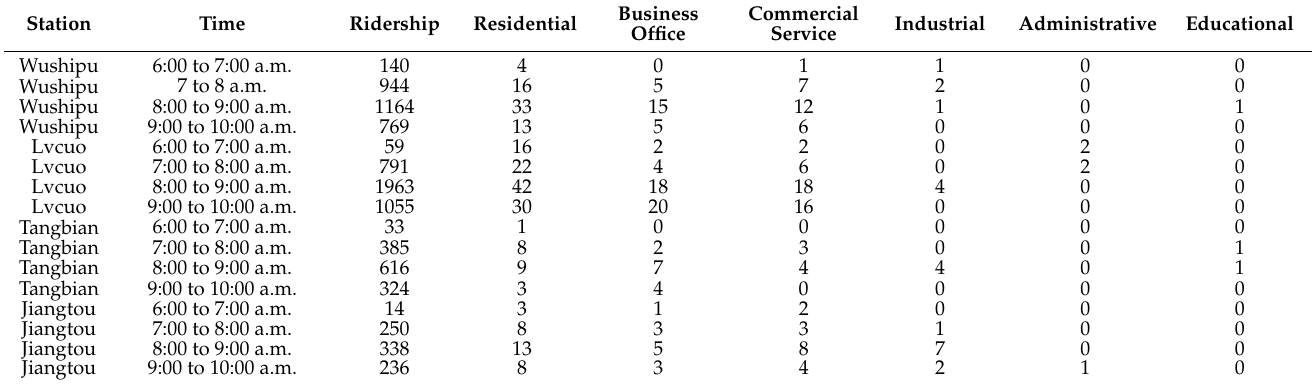
Table 2. Urban rail station egress ridership distribution with land use pattern.